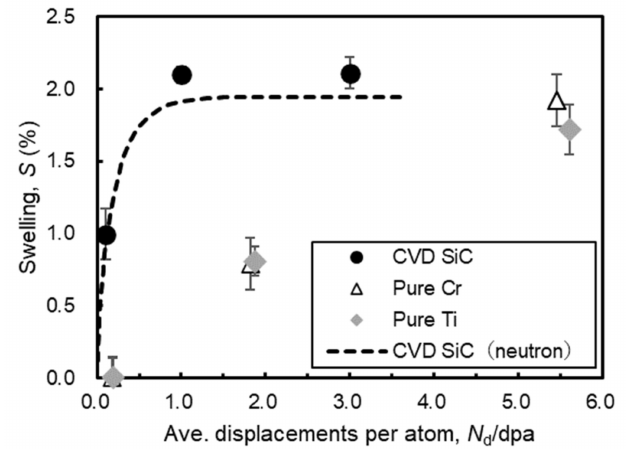
Figure 14. Changes in swelling of pure Ti, pure Cr and CVD SiC. The abscissa is the average number of displacements per atom for each material.